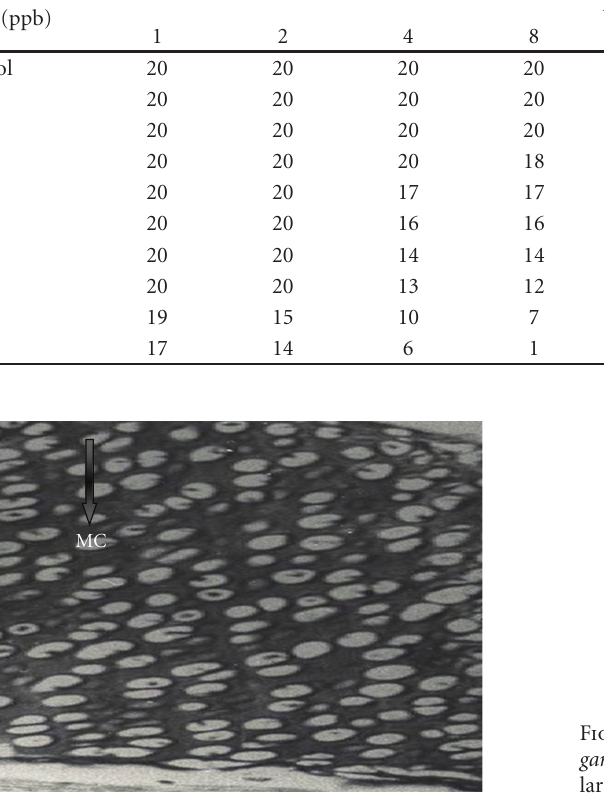
Figure 5: Plate of photomicrographof gill of Clarias gariepinus after 12 weeks of exposure to 22ppb of gammalin 20 showed numerous mucus cells, distortion, separation of the layers and sloughing.